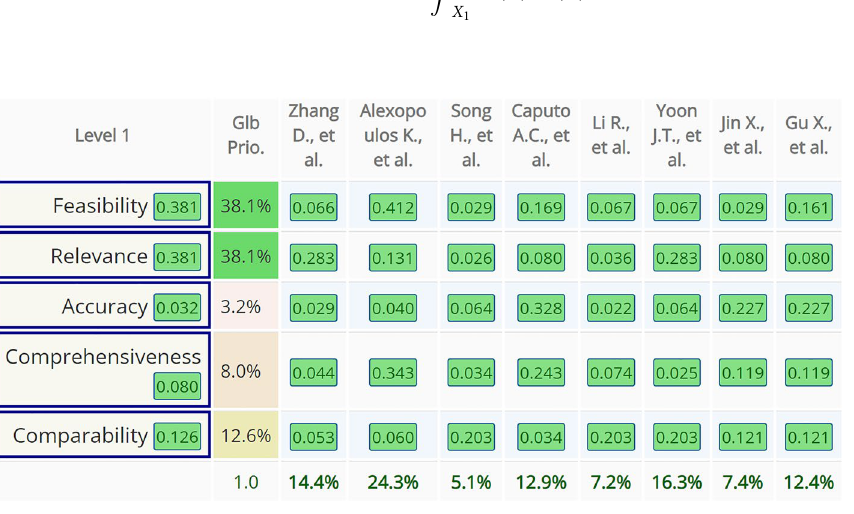
Figure 8. Decision matrix with comparison criteria weights, resilience metrics consolidated priority scores, and final AHP analysis results comparison (screenshot from AHP-OS